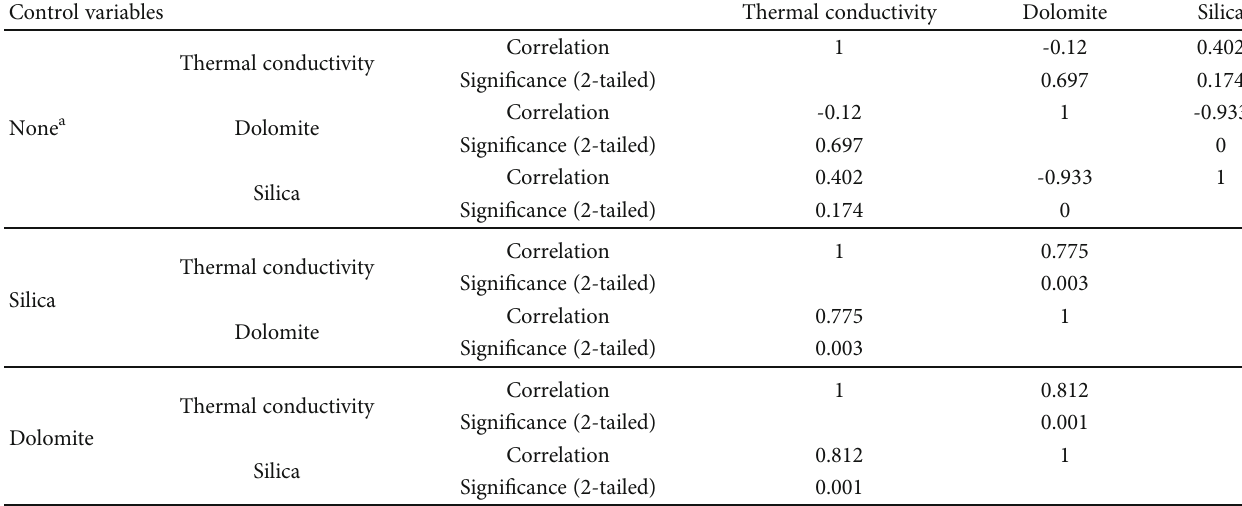
Table 11: Partial correlation analysis results of dolomite rock.